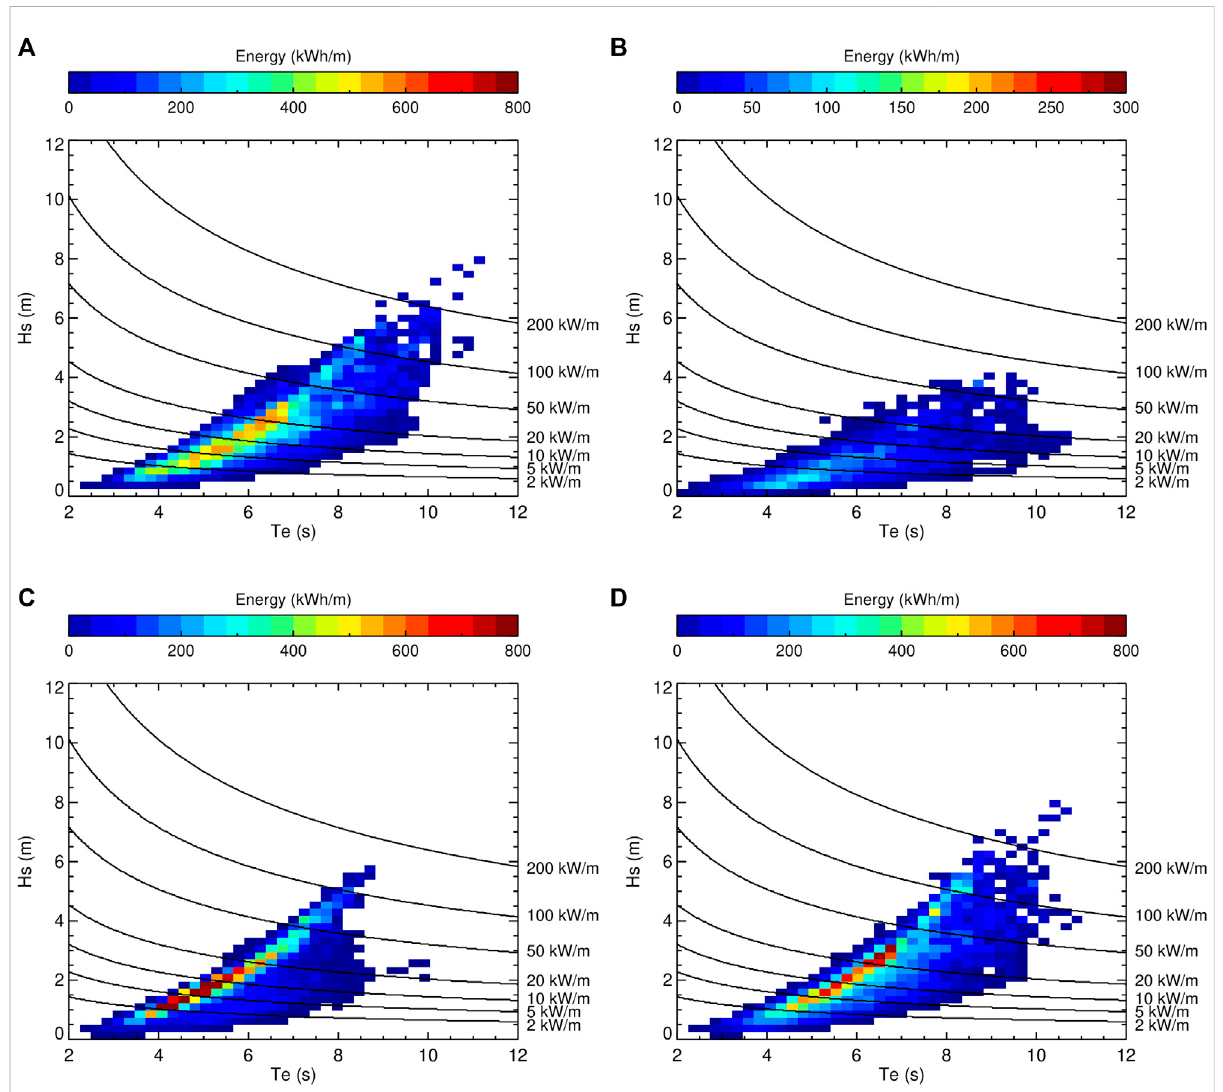
FIGURE 9 Distribution ofaverageannualwaveenergyasafunctionofsigni fi cantwaveperiodandsigni fi cantwaveheight,forsitesCR-1 (A) ,CR-2 (B) ,CR- 3 (C) , CR-4 (D) of Figure 7. Dotted lines mark reference power